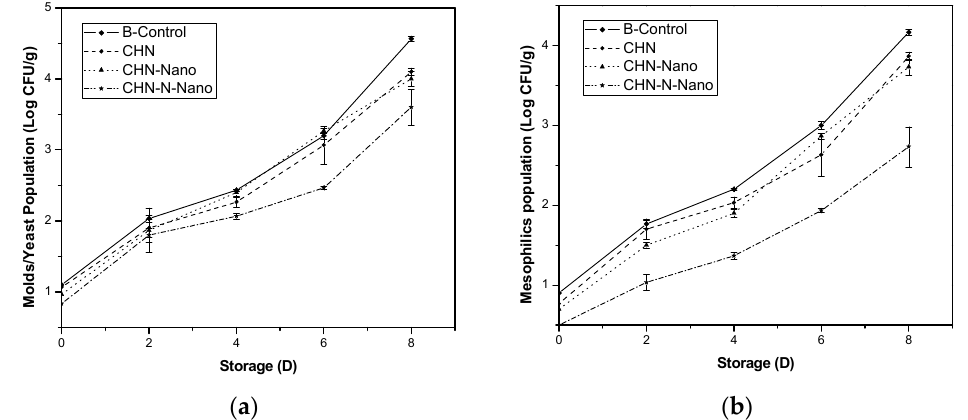
Figure 7. Antimicrobial effect of chitosan, nisin, silicon dioxide nanoparticles coatings on blueberries, ( a ) Molds/yeast population and ( b ) Mesophilics population counts.